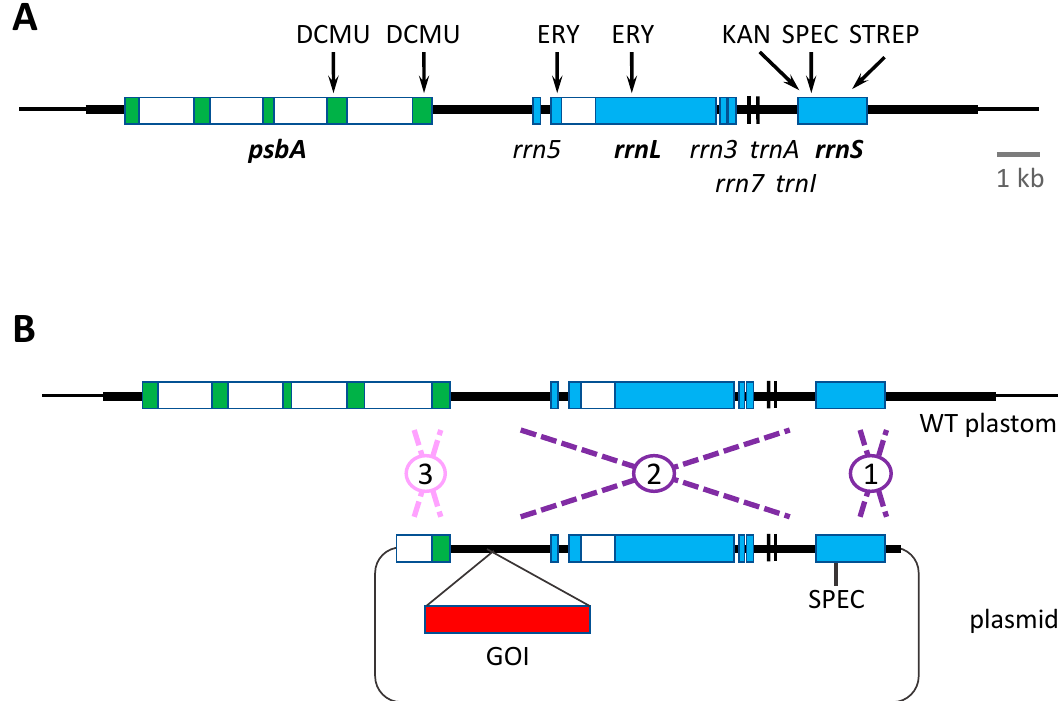
Figure 3. Dominant mutations in C. reinhardtii chloroplast genes that can be used for selection. ( A ) The gene organization within the inverted repeat region (thick black line) of the plastome with the location of point mutations in psbA giving rise to herbicide resistance (DCMU), those in rrnL conferring erythromycin resistance (ERY), and those in rrnS conferring resistance to kanamycin (KAN), spectinomycin (SPEC) and streptomycin (STREP) [45,47]. Introns in psbA and rrnL are indicated as white boxes. ( B ) The constraints of using such markers. Targeting a GOI to a neutral site such as downstream of psbA using SPEC, for example, involves constructing a large plasmid in which the GOI and SPEC are separated by many kilobases. In this situation, integration via a double crossover is much more likely to occur as events 1 + 2 rather than 1 + 3, resulting in a preponderance of ‘marker-only’ transformants. A separation of only a few hundred bases can still give rise to a significant percentage of such transformants [12]. WT =